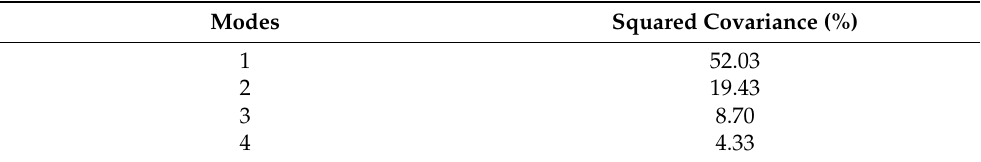
Table 4. Percentage of squared covariance explained by the first four modes of variability of the residuals of the pair Up–SP.